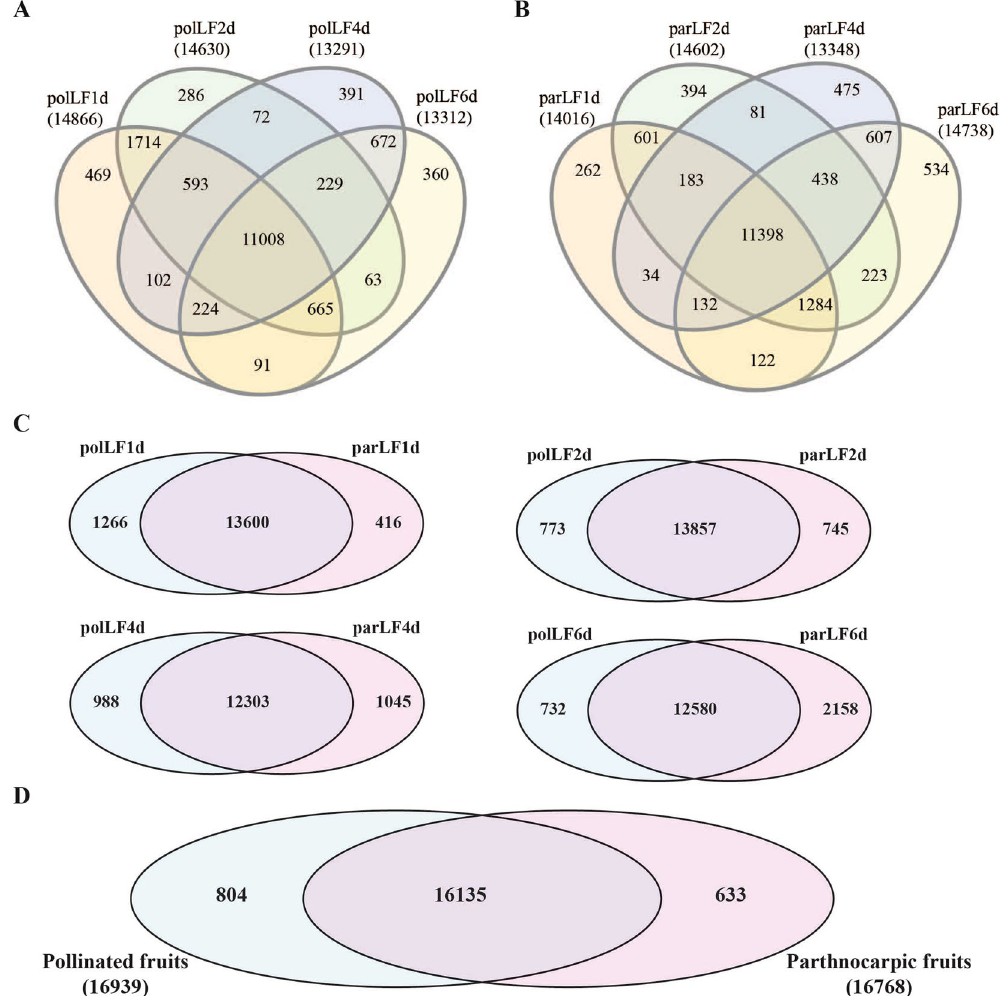
Figure 1. Overview of polLFs and parLFs transcriptomes. ( A ) and ( B ) are the Venn diagrams of commonly/ specifically identified genes in polLFs and parLFs, respectively. ( C ) Comparisons of identified genes in polLFs and parLFs at different stages. ( D ) Overall of the identified genes in polLFs and